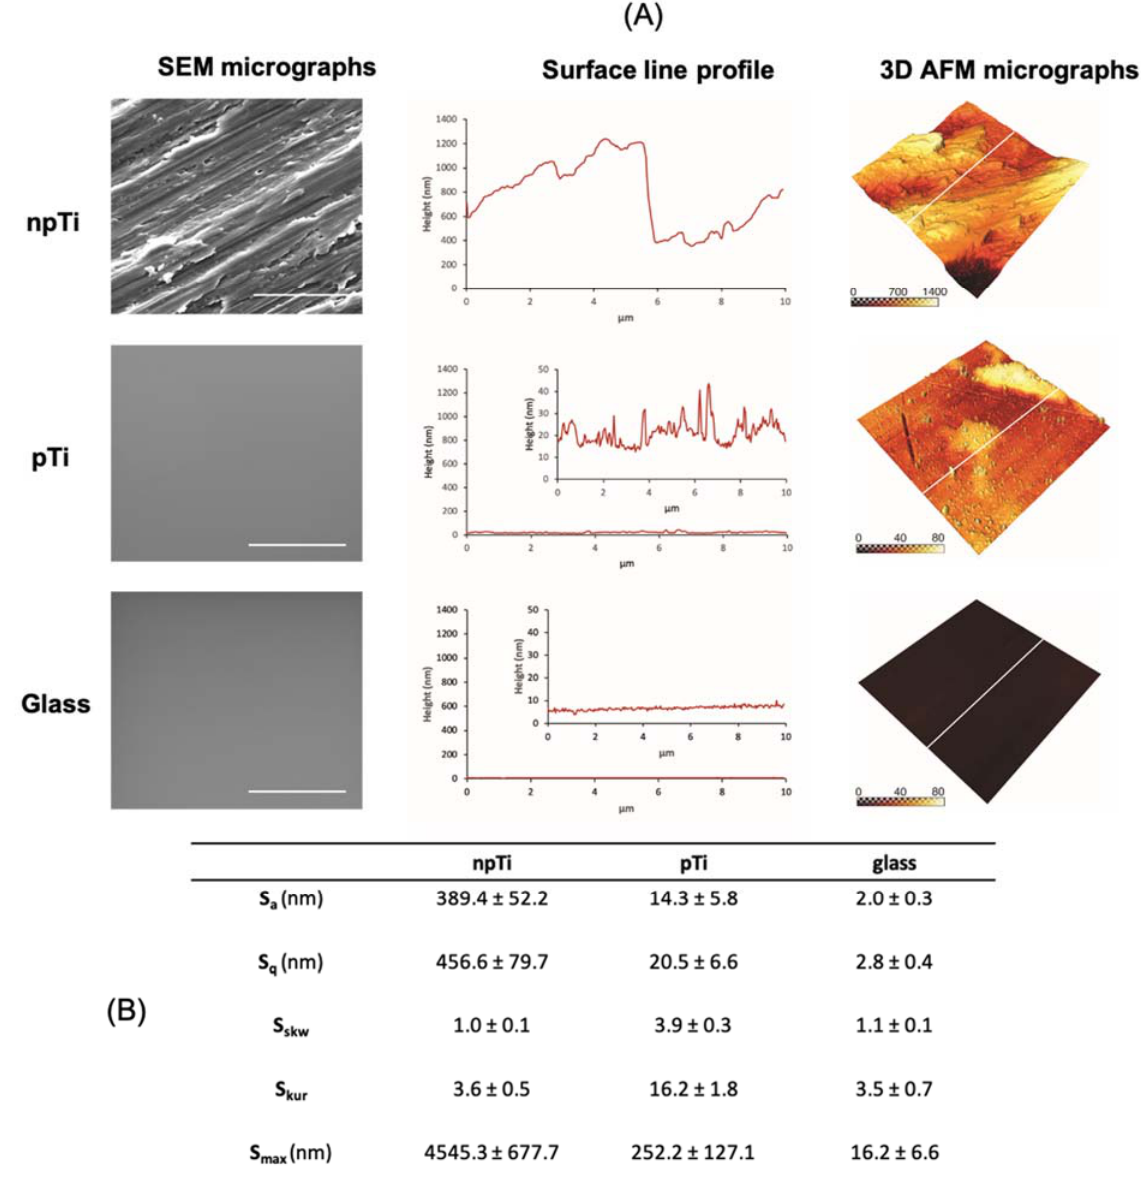
Figure 1. Surface topographic analysis of npTi, pTi, and glass surfaces. ( A ) SEM micrographs, AFM line profiles (scale bar = 50 µm), and corresponding 3D visualization of AFM micrographs showing the surface roughness of each respective sample. ( B ) Surface roughness parameters of the three studied surfaces as derived from 10 × 10 µm 2 AFM scanning areas. The resolution of each scan was 256 × 256 pixels, n = 5.